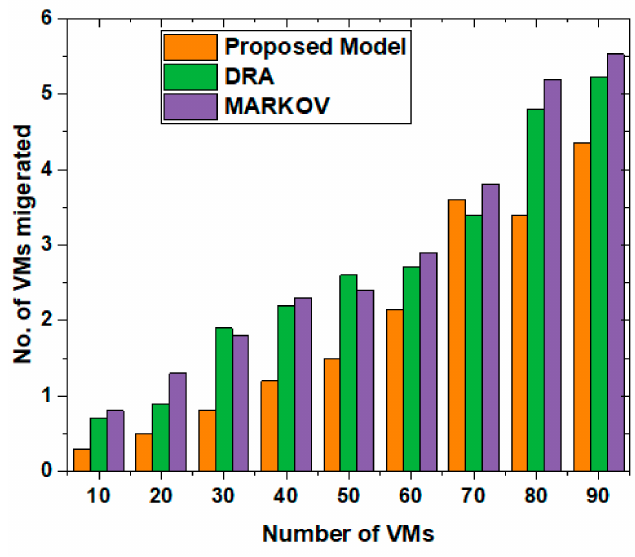
Figure 14. Comparison of VMs for tasks migration.